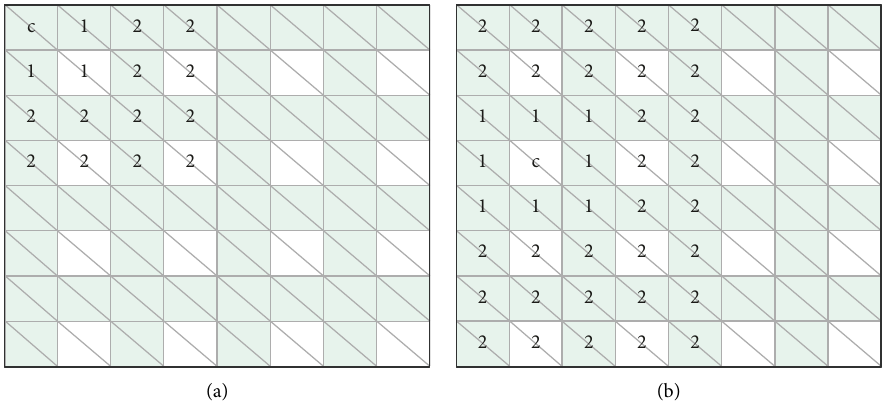
Figure 1: Boundary case. (a) One of the boundary cases. (b) Boundary case